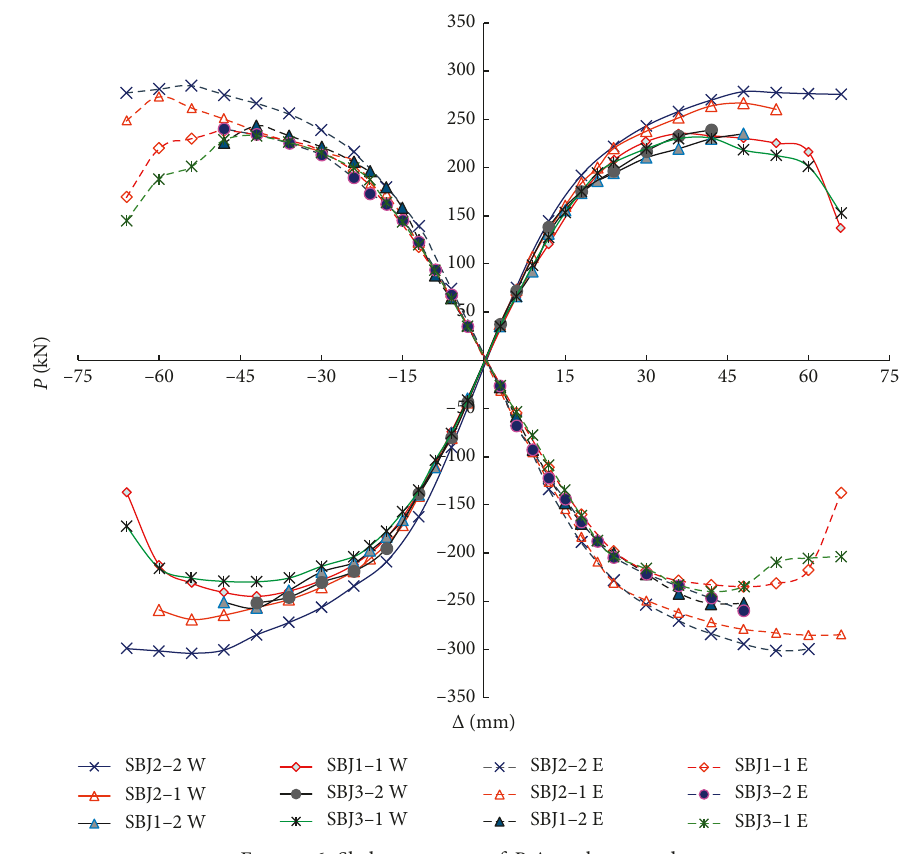
Figure 6: Skeleton curves of P - Δ on beam ends.